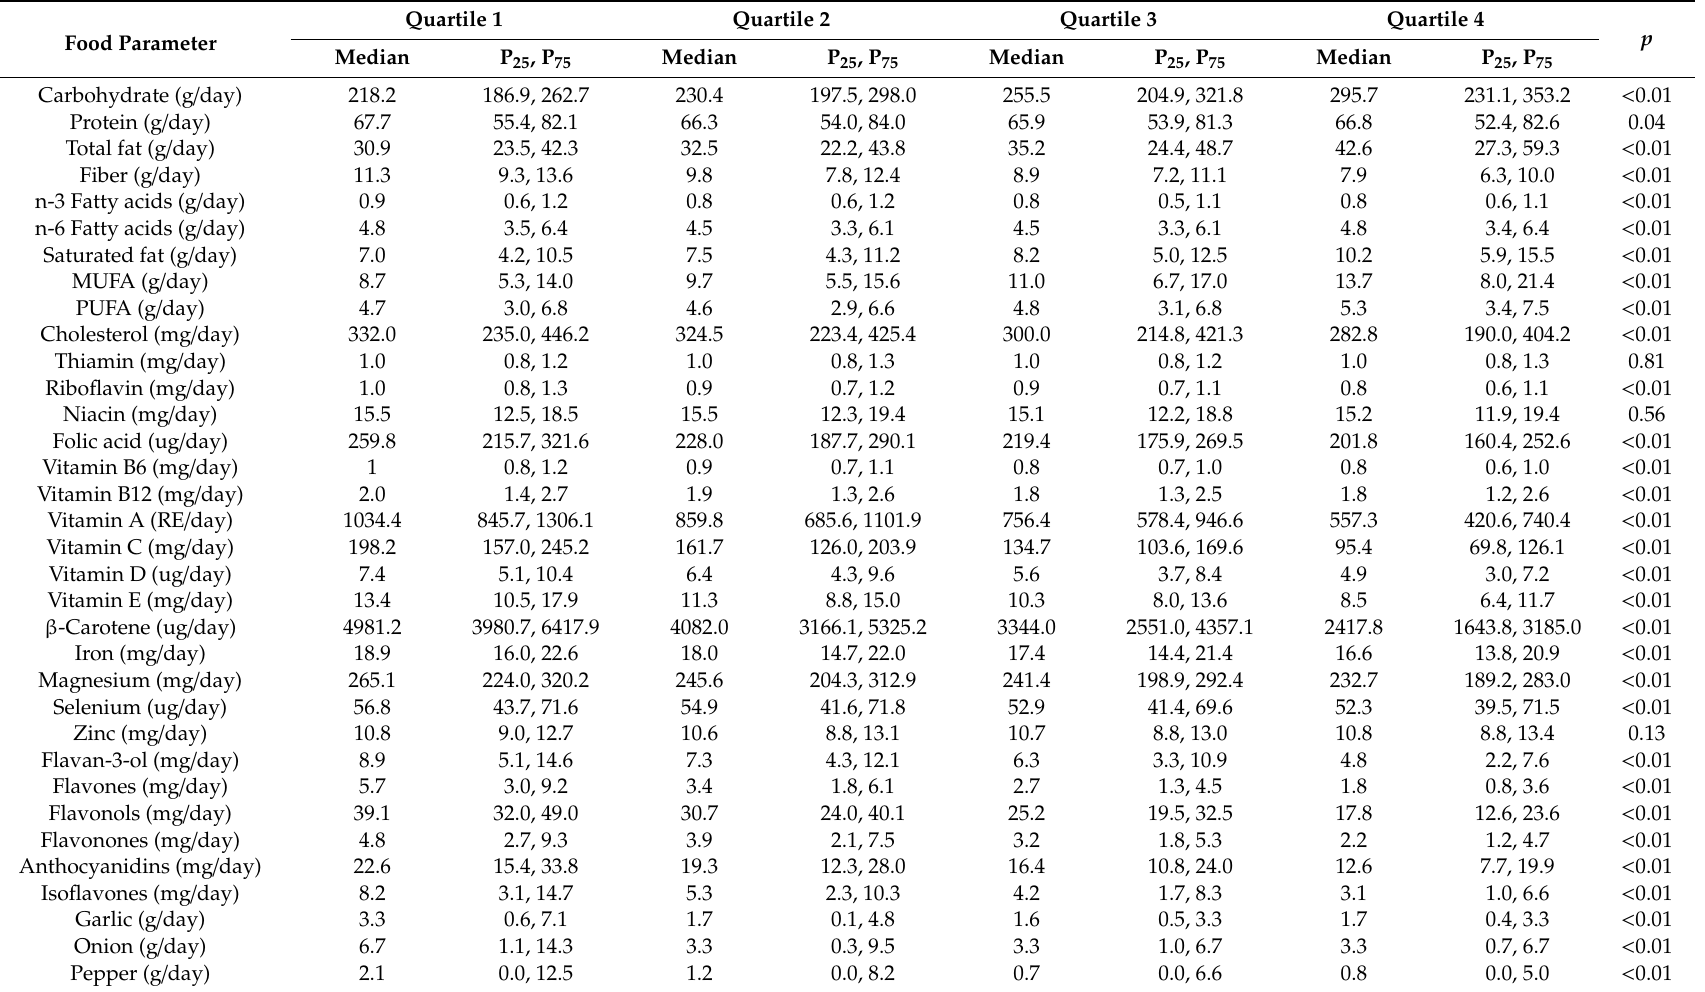
Table 2. Intakes of 34 food parameters according to quartile of the energy-adjusted dietary inflammatory index (E-DII) score among controls in a Chinese case-control study,